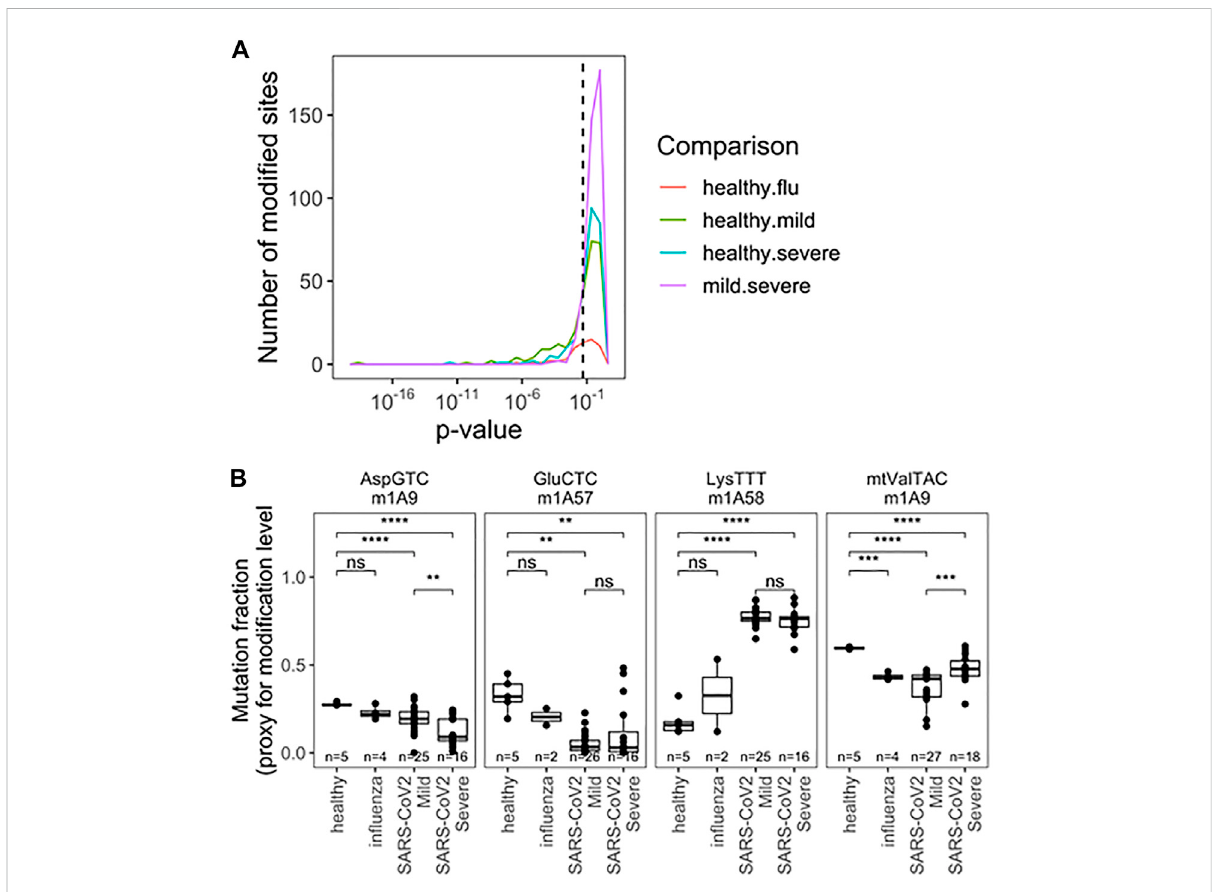
FIGURE 4 Rspeci fi c tRNA modi fi cation pro fi le in RNA obtained fromnasopharyngeal swabs allows for seperation of uninfected, in fl uenza and SARS-CoV- 2infected individualswith mildorsevereCovid-19 symptoms). (A) Uncorreced p -Valuesfor pairwise two-sided t -tests indicate differences amoung speci fi c tRNA modi fi cations. Modi fi cations are detected as a “ muation ” derived from reverse transcriptase disincorporation when reading modi fi ed bases.Analysisincludessiteswith > 2%mutationrateand > 50mappedreads.PrecisevaluesareindicatedintableS4. (B) Modi fi cationsexhibiting notable patterns are highlighted m 1 A9 on tRNA Asp (GTC), m1A58 on tRNA Glu (CTC), m1A58 on tRNA 1ys (TTT),m 1 A9 on mt-tRNA Val (TAC). p -values.* < 0.05; ** < 10 − 2 ;*** < 10 − 3 ;**** < 10 − 4 . Two-side t -tests with the number of samples passing a 50 read fl iter indicated on each plot-the 2% mutation rate fi lter was relaxed after individual sites were